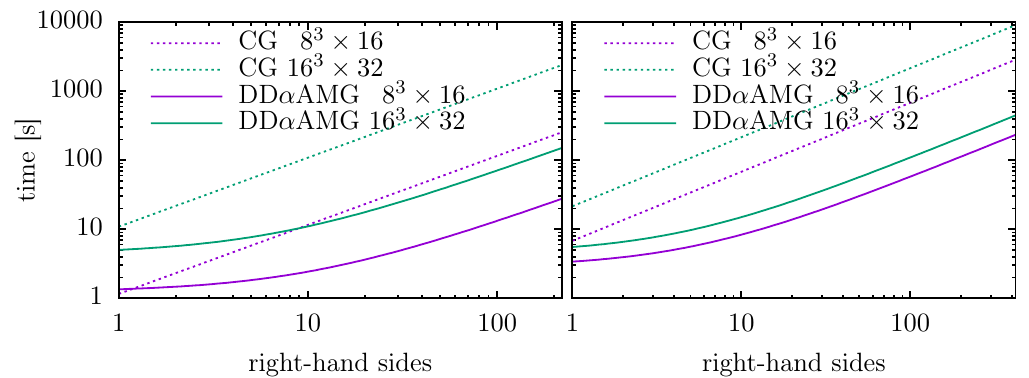
Figure 17 . Left/Right: measured time in seconds to invert the Wilson Dirac operator for different numbers of right-hand sides in the fundamental/adjoint representation of SU(3). The different colors correspond to the lattice sizes 8 3 × 16 resp. 16 3 × 32 . Solid (dotted) lines are for the DD α AMG (CG) inverter. Note the double-logarithmic